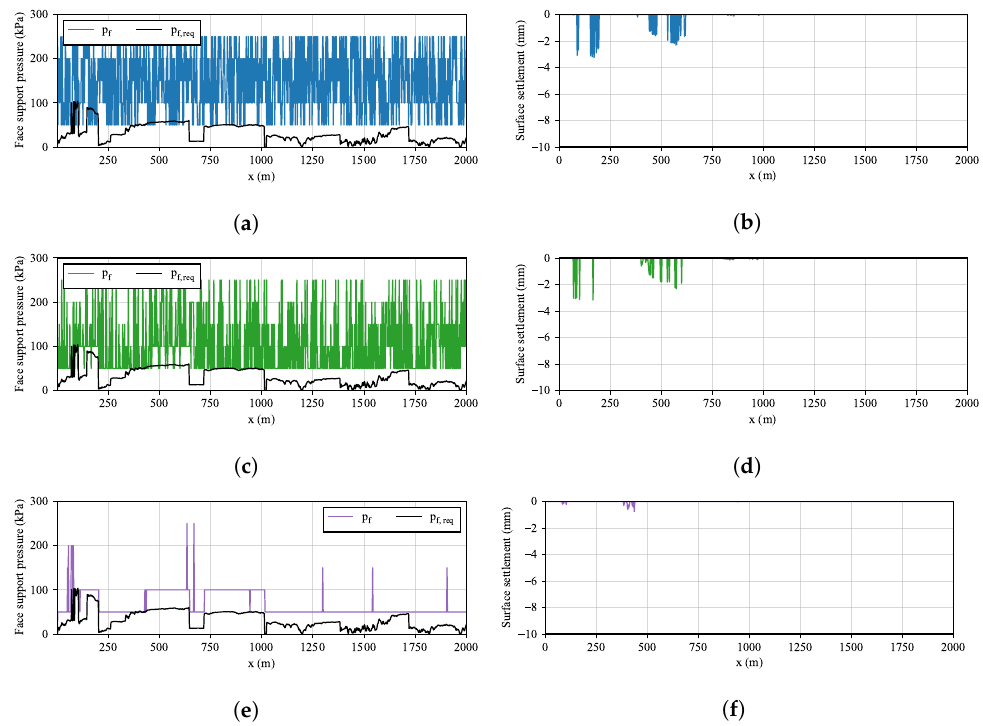
Figure 6. Required and provided support pressure and settlement in the analytical environment with constant geology at episodes ( a , b ) 1, ( c , d ), 50, and ( e , f )